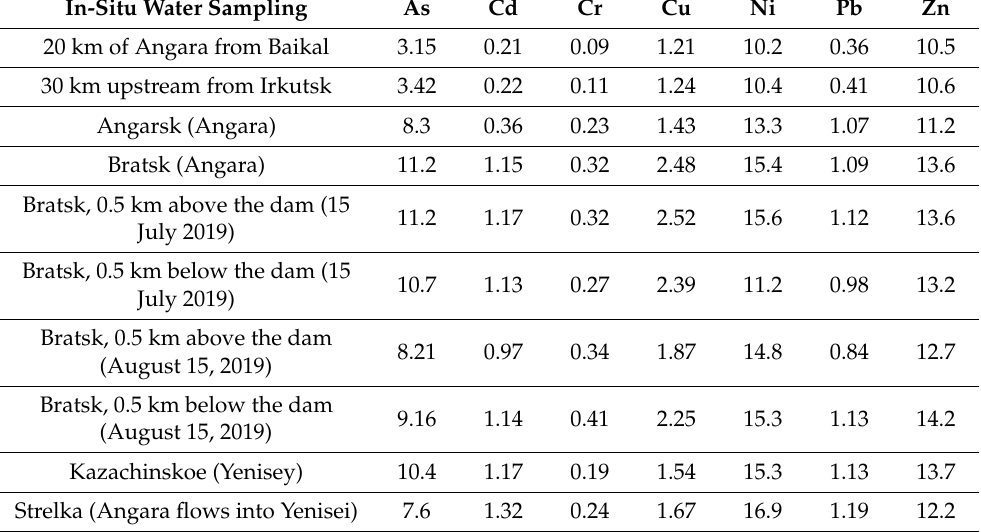
Table 3. Concentration of heavy metals ( µ g/L) in the water samples of the Angara River evaluated on the basis of the US-8